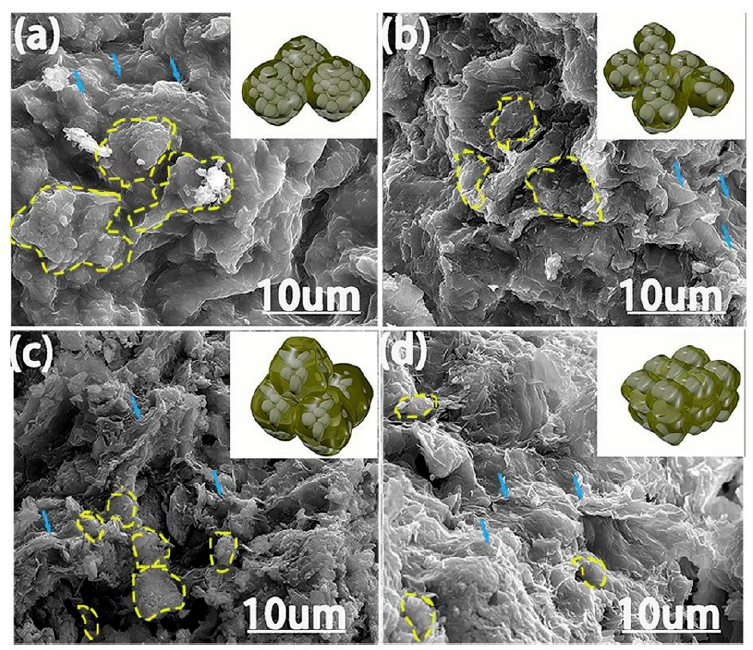
Figure 22. SEM images of hydrated geopolymer particles encapsulated by graphene oxides sheets ( a – d ), and their models. With the increase of GO concentration from 4 wt% to 20 wt% in nanocomposites, the agglomerate size (showed by dotted-line circles) decrease. Reproduced from [209], with permission from Elsevier, 2017.